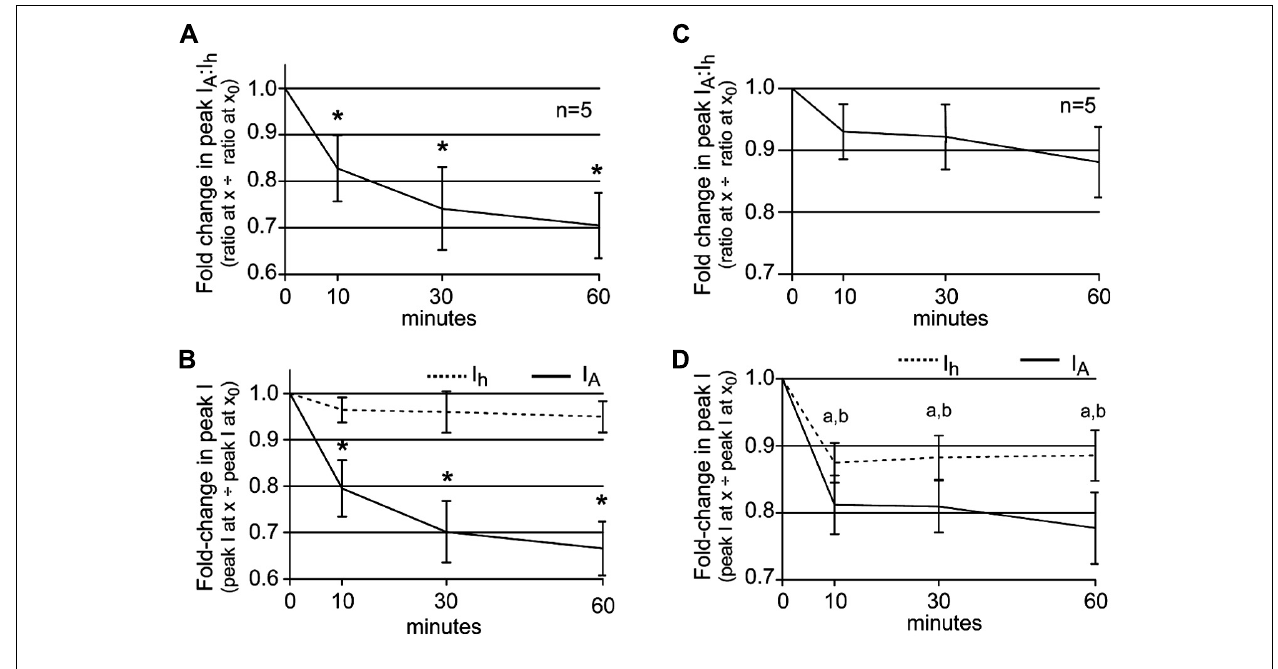
FIGURE 5 |The LP I A : I h ratio is maintained in 5 μ M DA when DA application is accompanied by DA-induced changes in slow wave activity. (A) A plot of the fold-changes in the LP I A : I h ratio (mean ± SEM) throughout a 1 h superfusion with 5 μ M DA and implementation of a recurring voltage step that mimicked the DA-induced 30% decrease in LP burst duration, but no change in cycle frequency.The ratio significantly decreased with time; repeated measures ANOVA with Dunnett’s post hoc tests that compare all time points to t = 0, F (3,4) = 7.322, p = 0.0032. (B) Plots of the fold-changes in peak LP I A and I h (mean ± SEM) from the same experiments as in (A) . Repeated measures ANOVAs with Dunnett’s post hoc tests that compare all time points to t = 0 indicate that only LP I A was